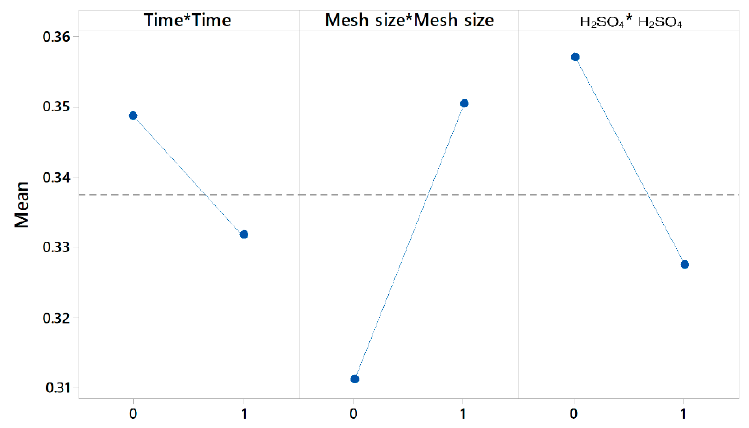
Figure 4. Interaction effect plot for Mn extraction.